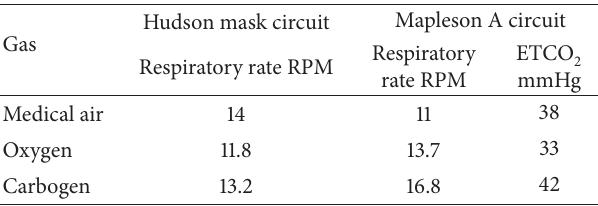
Table 1: End tidal CO both